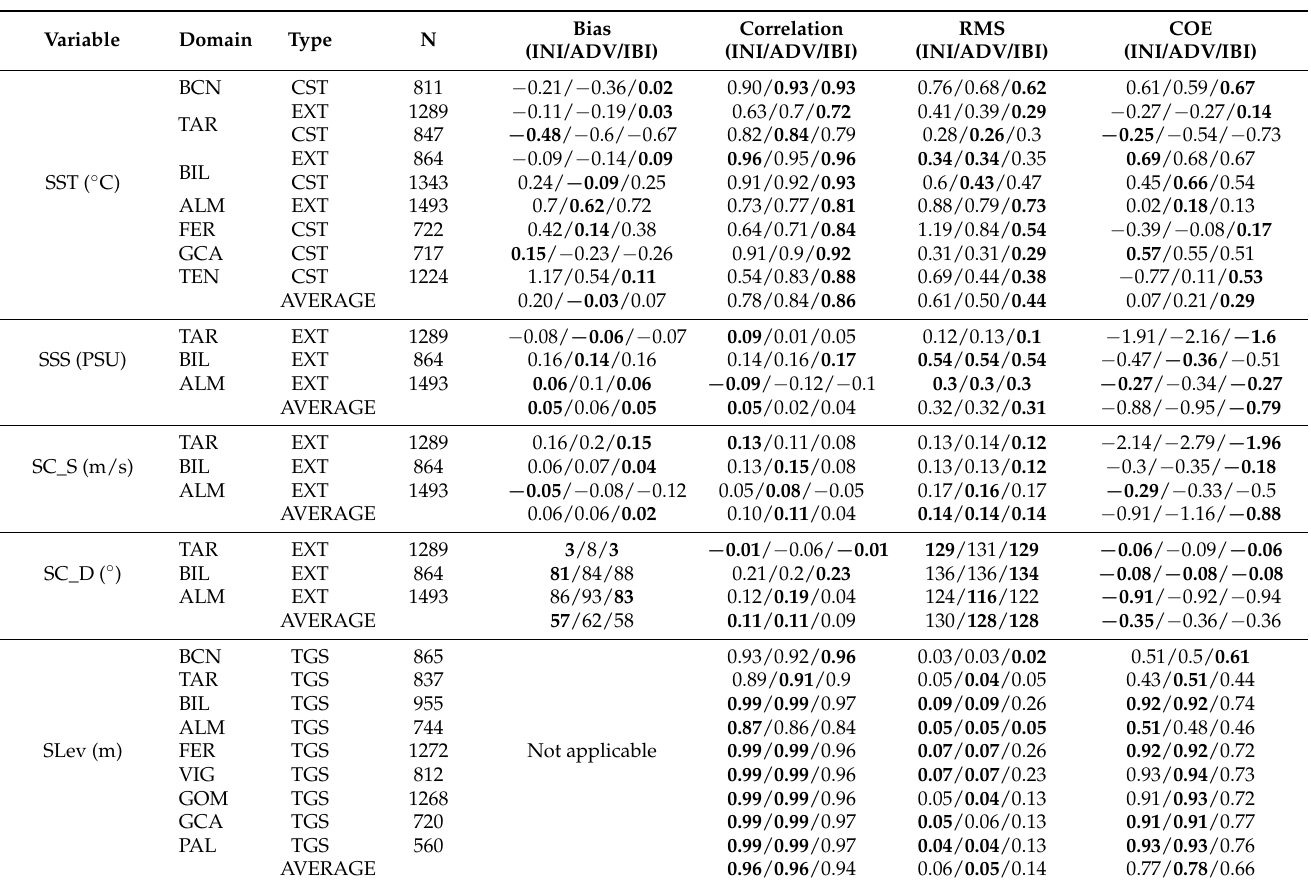
Table 3. Error metrics for the SAMOA SAM_ADV and SAM_INI test runs, plus the IBI_PHY parent solution (computed with hourly observations). The metrics comprise the June 2019 period. Variables: SST (Sea Surface Temperature in ◦ C), SSS (Sea Surface Salinity, in PSU), SC_S (Surface current speed, in m/s), SC_D (Surface current direction, in ◦ ), SLev (sea level, in m). The domain column identifies the SAMOA system. The Type denotes the sensor type used: TGS (Tide Gauge Station), CST (Coastal Buoy), EXT (Deep-water buoy). N counts the size of the sample (conditioned by the availability of hourly observation). Each error metric (Bias, Correlation, Root-Mean-Square Error (RMS) and Coefficient of Efficiency (COE)) provided for each model solution (SAM_INI (INI), SAM_ADV (ADV) and IBI_PHY(IBI)). The last row of each variable represents the average error metric of all the sensors given a specific test run. Bold numbers highlight the best performing